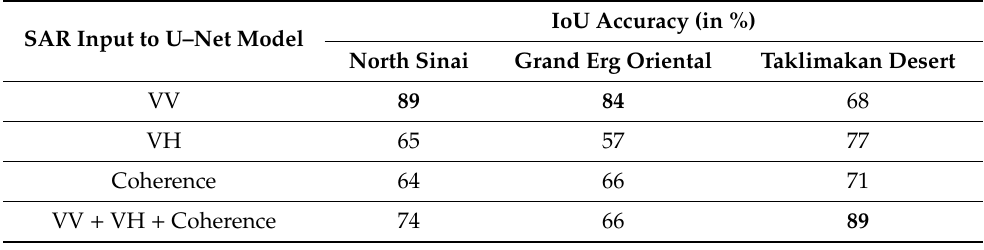
Table 3. Intersection over union (IoU) accuracy of road detection models with di ff erent SAR input types. The best results for each area are highlighted in bold.